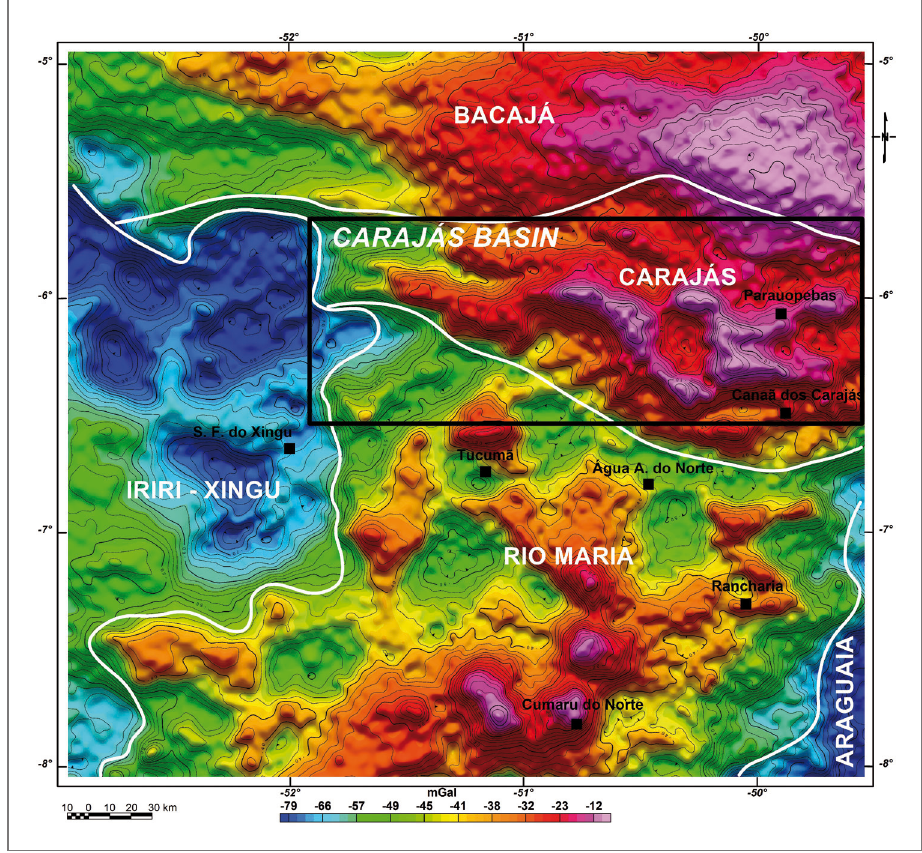
Figure 2 - Bouguer gravity anomalies of the “Levantamento Aerogravimétrico Carajás” project with overlapping of the boundaries of the gravity domains with designation according to the tectonic framework from Vasquez et al. (2008). The location of the Carajás Basin is